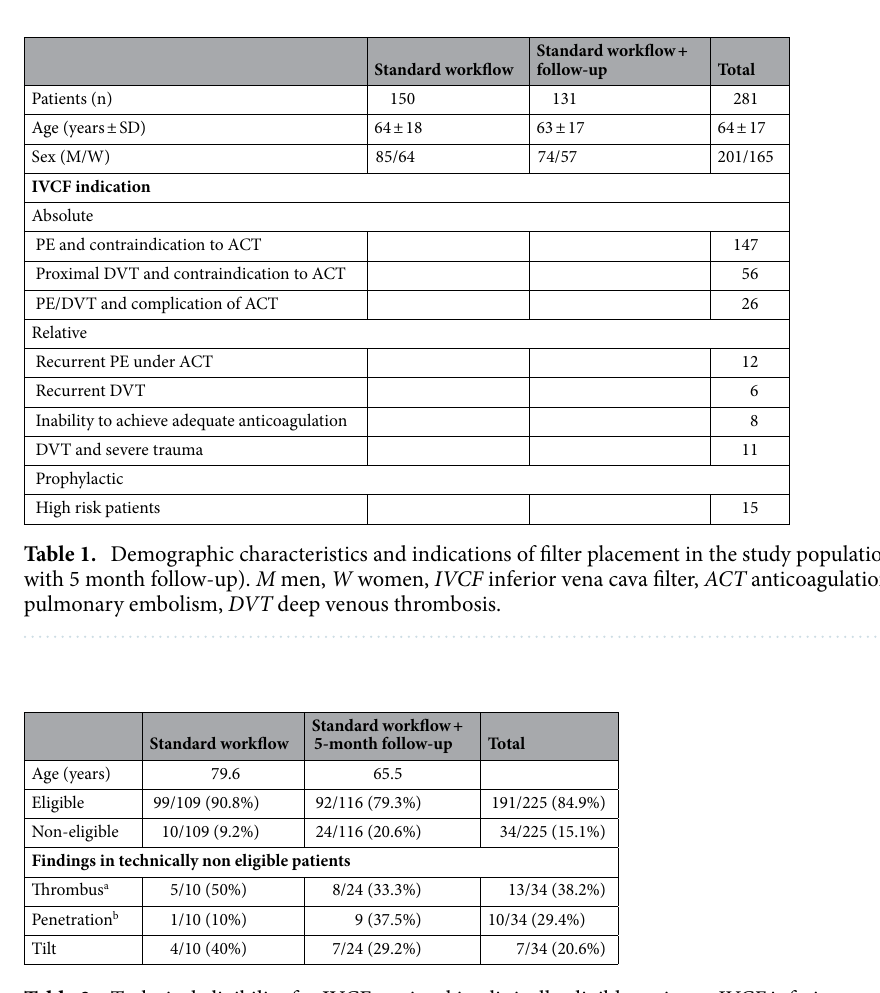
Table 2. Technical eligibility for IVCF retrieval in clinically eligible patients. IVCF inferior vena cava filter. a Volume thrombus within the filter more than 30%. b Patients with transmural deep